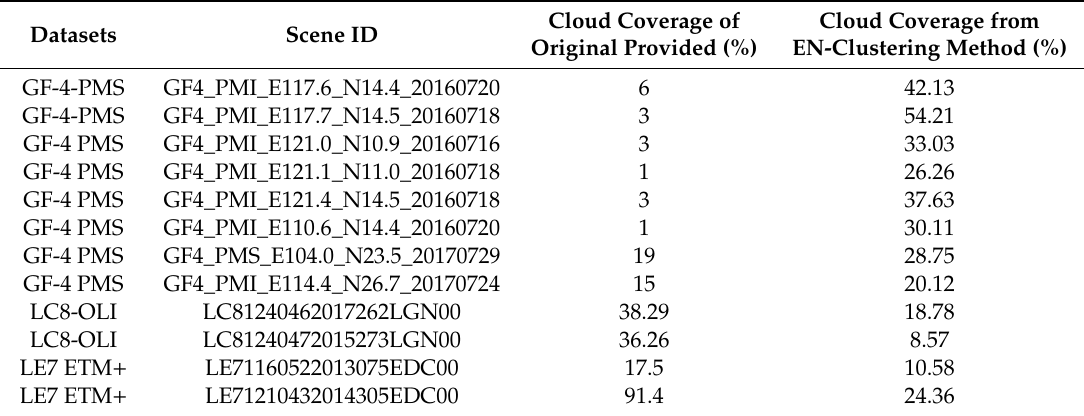
Table 3. Comparison of cloud coverages between the o ffi cial method and the EN-Clustering method. Datasets Scene ID